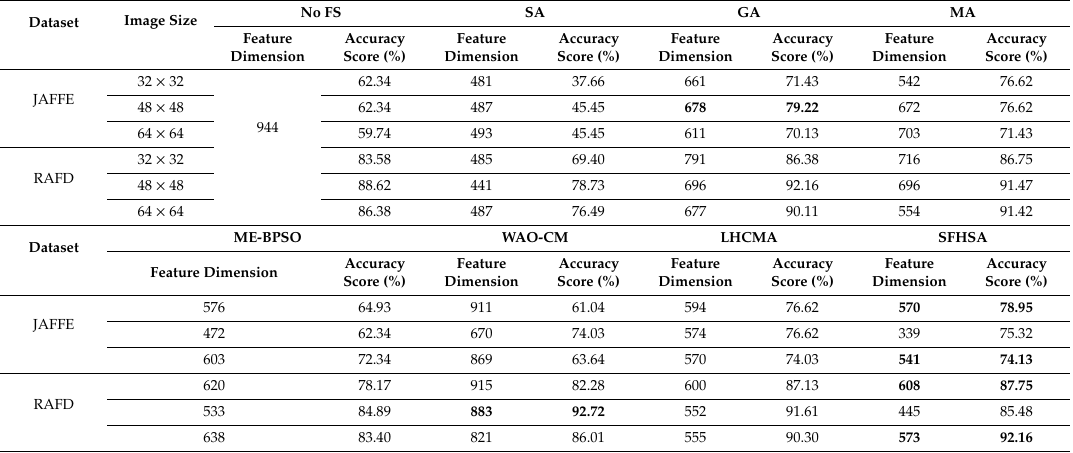
Table 3. Performance of SFHSA with respect to No FS, SA, GA, MA, ME-BPSO, WAO-CM and LHCMA for uLBP features.